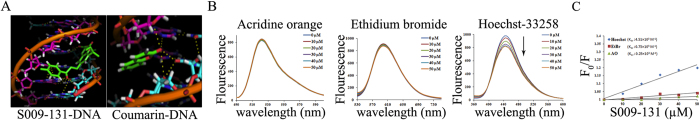
S009-131 binding to minor groove of DNA.(A) Comparative molecular docked structures of S009-131 and coumarin complexed with DNA showing specific minor groove binding. (B) Fluorescence spectral patterns for competitive displacement assay with different DNA interacting agents in presence of S009-131. (C) Stern-Volmer plot was sketched from fluorescence spectral data to calculate KSV (Stern-Volmer constant) values.